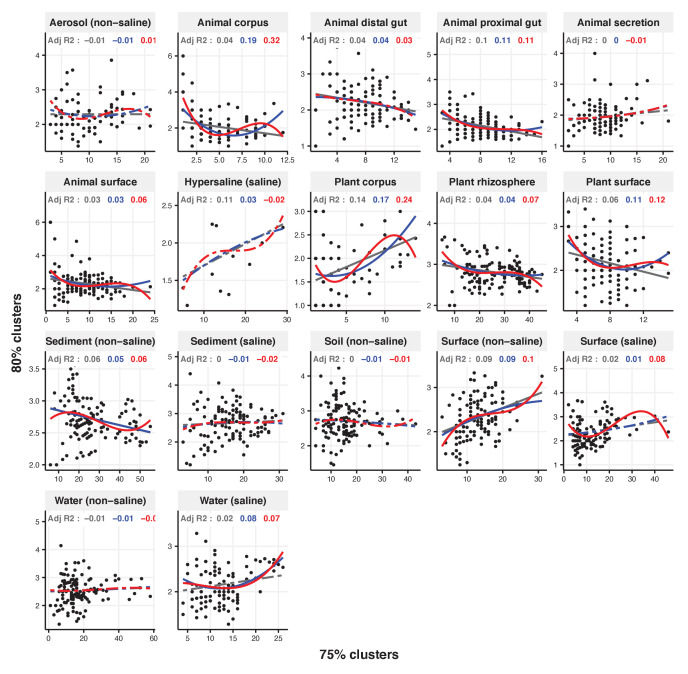
Focal clusters at 75% nucleotide identity.Community diversity was estimated as the number of clusters at a focal level (di) and focal lineage diversity as the mean of the clusters at the rank above (di 1/di). Linear (grey), quadratic (blue) and cubic (red), with corresponding adjusted R-squared values in the same colour. P-values are Bonferroni corrected for 17 tests. Significant, p<0.05 (solid lines), non-significant (dashed lines). The x-axis shows the number of clusters at the focal percent-identity level (di), and the y-axis is the mean of the clusters at the rank above (di 1/di).